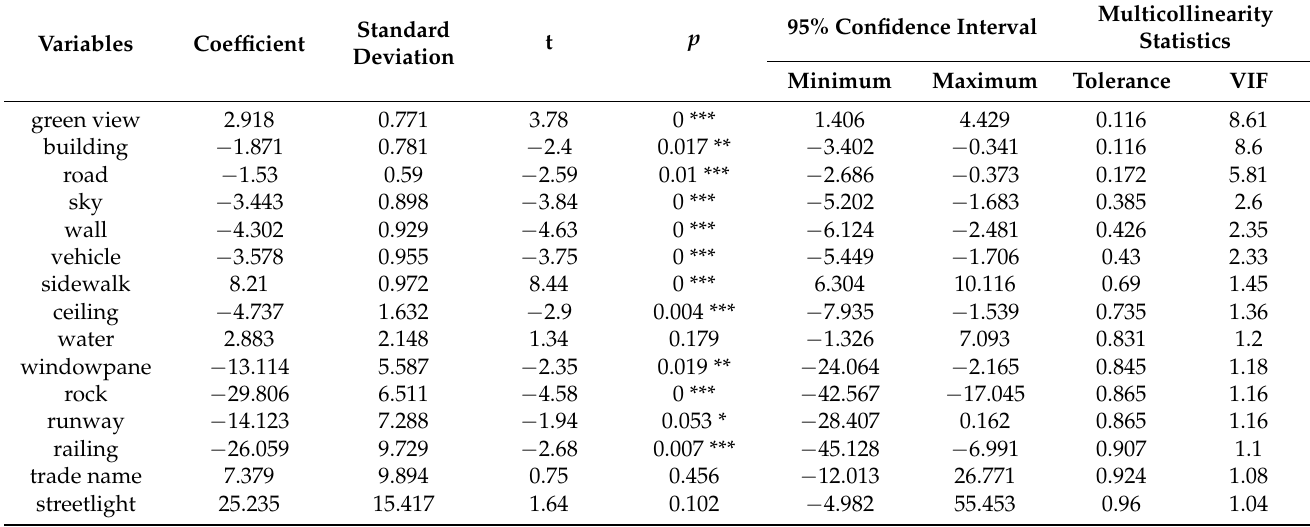
Table 3. The Result of Correlation